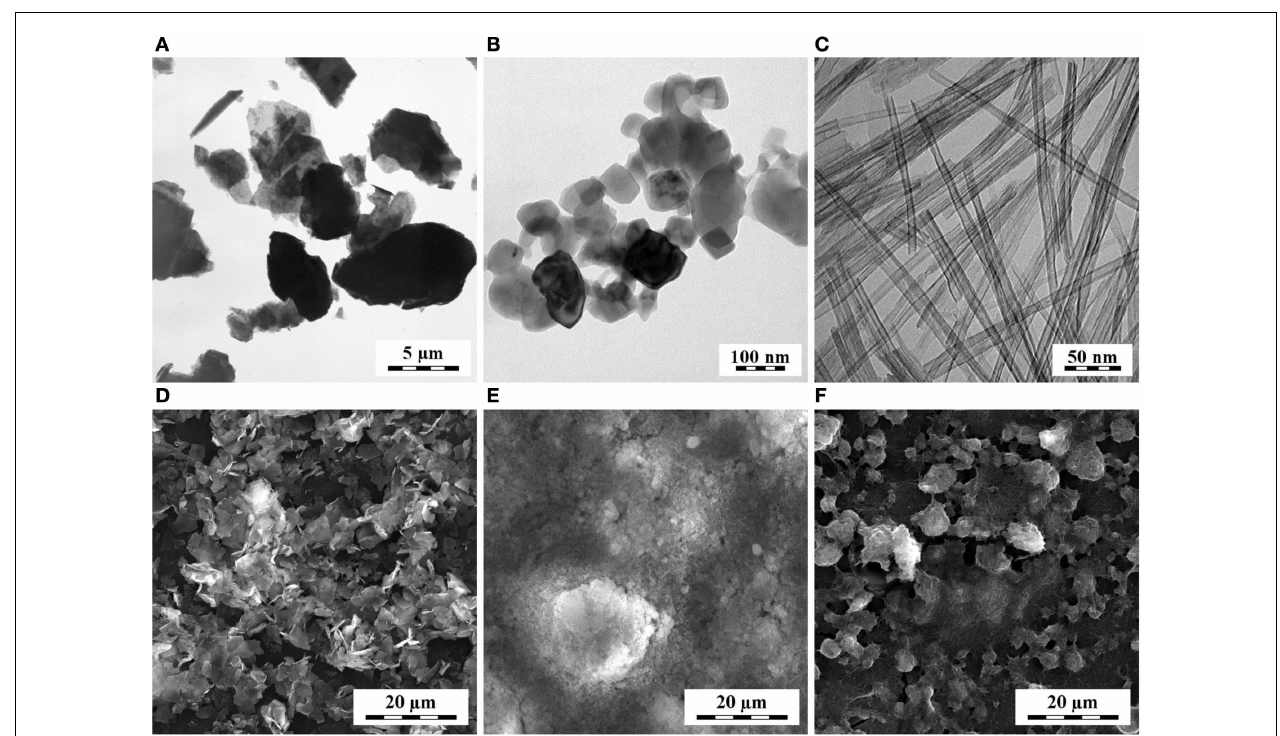
FIGURE 2 | Morphology of talc microparticles (A,D), chalk nanoparticles (B,E), and titanate nanotubes (C,F):TEM micrographs of individual particles (A–C) and SEM micrographs of their layers on polymer films (D–F) .